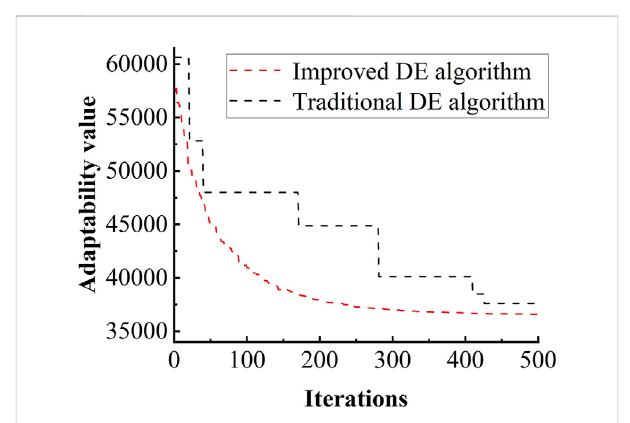
FIGURE 7 Comparison between improved DE algorithm and traditional DE